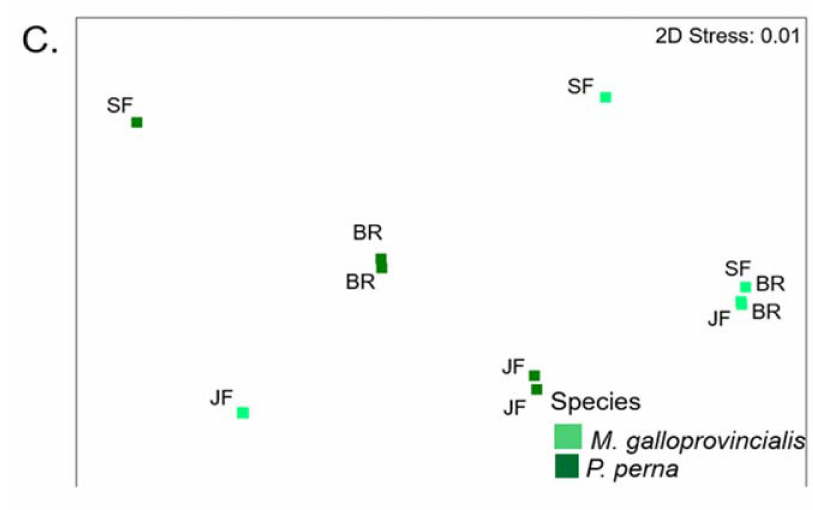
Figure 6. Non-metric multidimensional scaling (NMDs), based on presence-absence of cyanobacterial species using Bray–Curtis distance for ( A ) Mytilus galloprovincialis , ( B ) Perna perna , ( C ) the two mussel species within the warm temperate